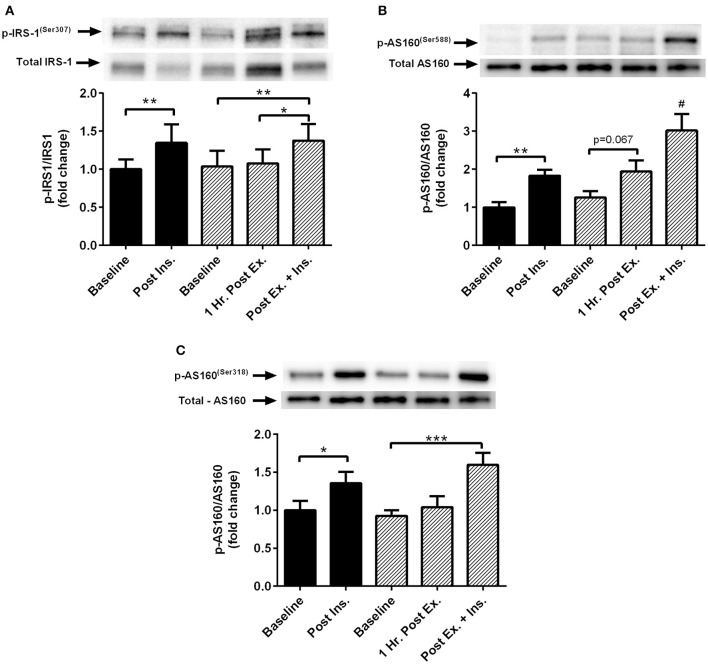
Exercise, insulin stimulation and skeletal muscle insulin signaling. Phosphorylation relative to total protein content of insulin signaling proteins in skeletal muscle 1 h after exercise (prior to insulin stimulation), and pre and post insulin stimulation at rest and 3 h after exercise (n = 11). (A) IRS-1(ser307); (B) AS160(ser588); (C) AS160(ser318). *p < 0.05, **p < 0.01, ***p < 0.001 and # is significantly different to all time-points in both the rest and exercise trial. Black bars = rest trial. Diagonal line bars = exercise trial. Ex. = High-intensity interval exercise. Ins. = insulin stimulation via the hyperinsulinaemic-euglycaemic clamp.